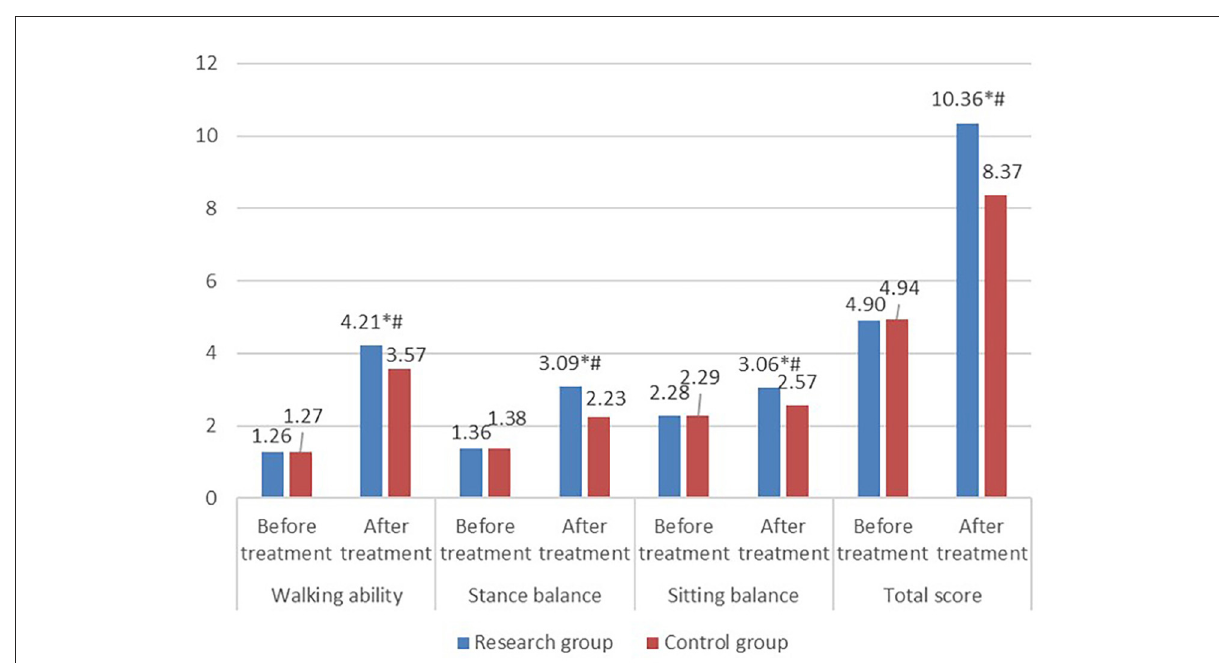
FIGURE2 Comparison of balance function scores between the two groups. Balance function in the research group including walking ability, stance balance, sitting balance, and total score improved after treatment. Additionally, balance function of the research group after treatment was significantly better than that of the control